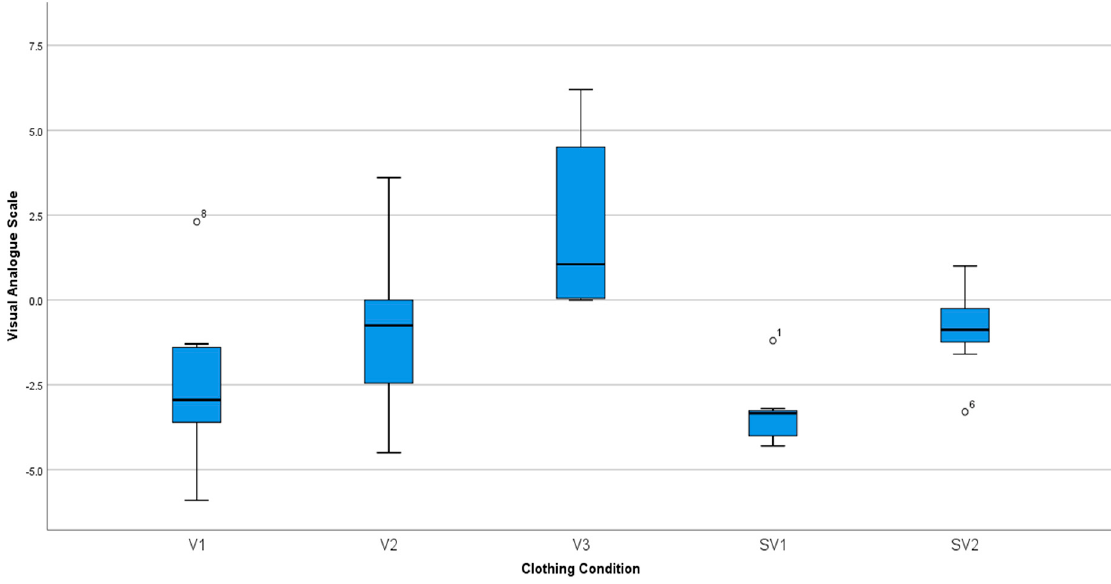
Figure 8. Subjective results of the Vertical Jump when compared to station wear.